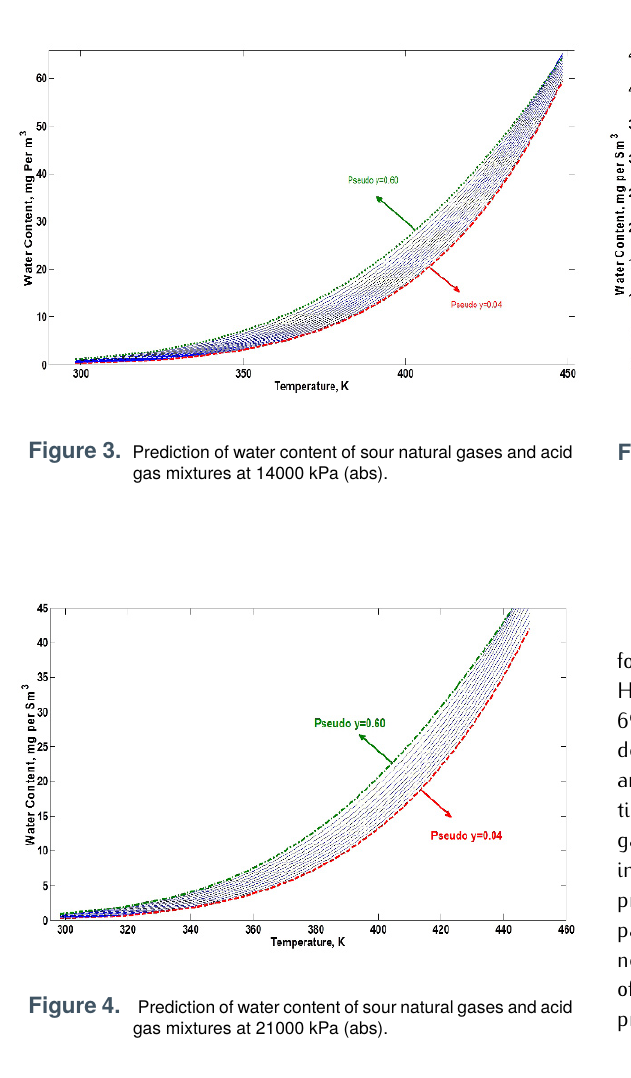
Figure 2. Performance of proposed predictive tool for estimation of water content of sour natural gases at 6900 kPa (abs).